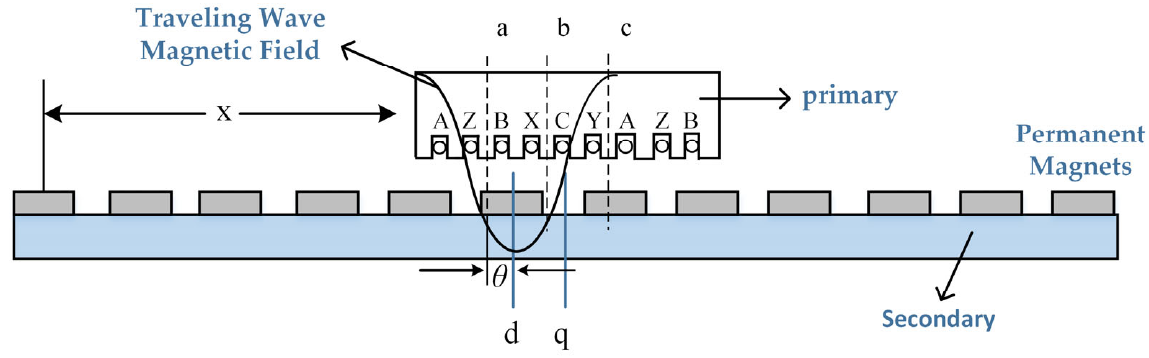
Figure 1. Working principle of the PMLSM.